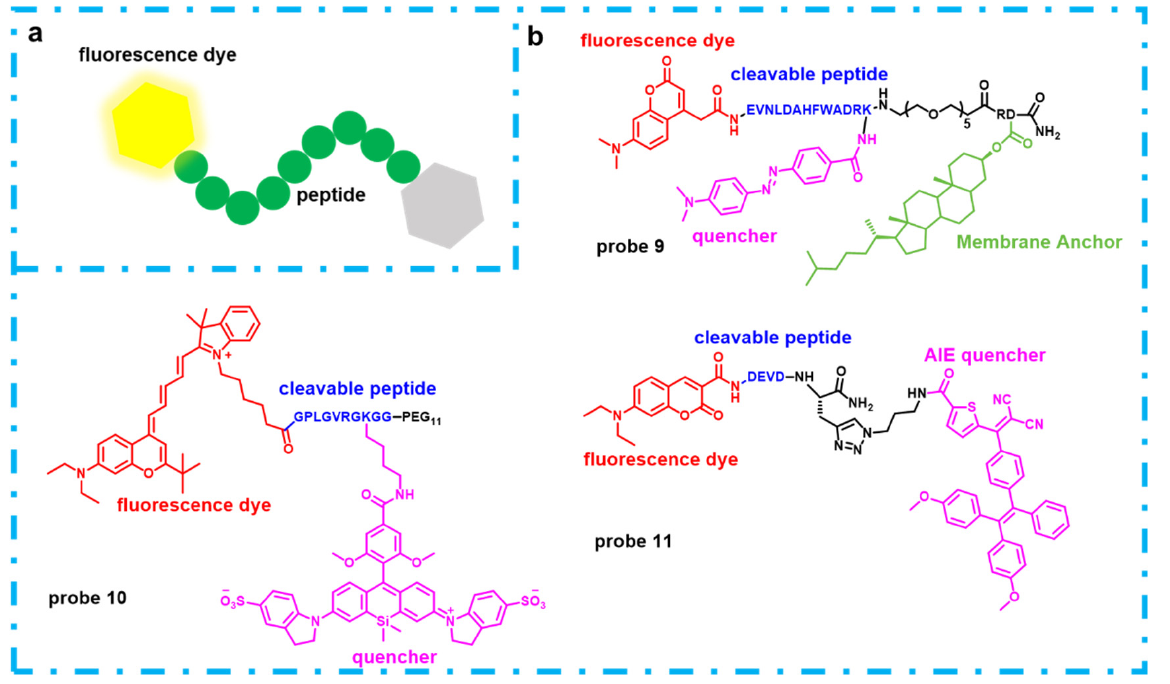
Figure 3. ( a ) The design strategy of the fluorescent probes for proteases; ( b ) Chemical structures and composition of probes 9, 10 and 11 .